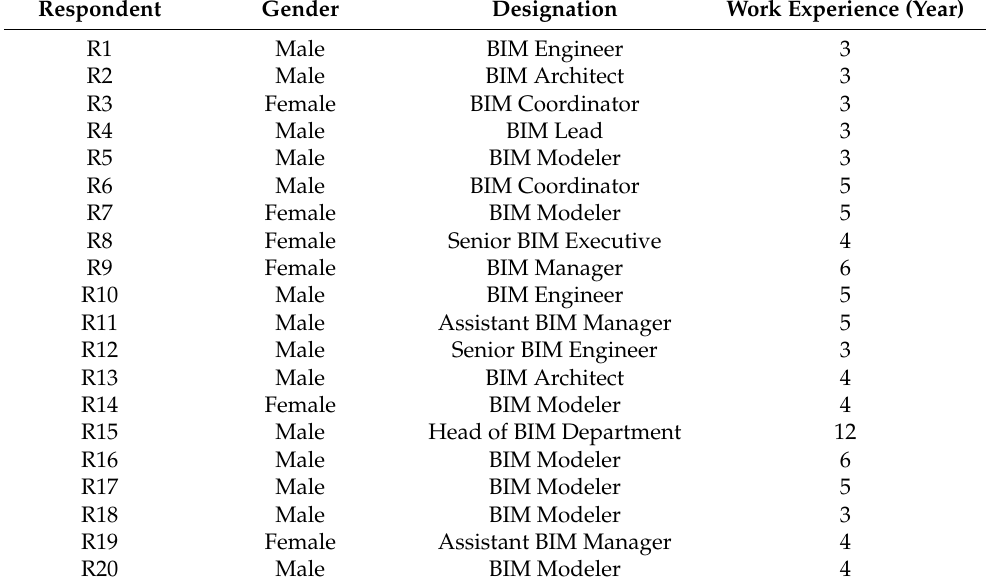
Table 2. Respondents’